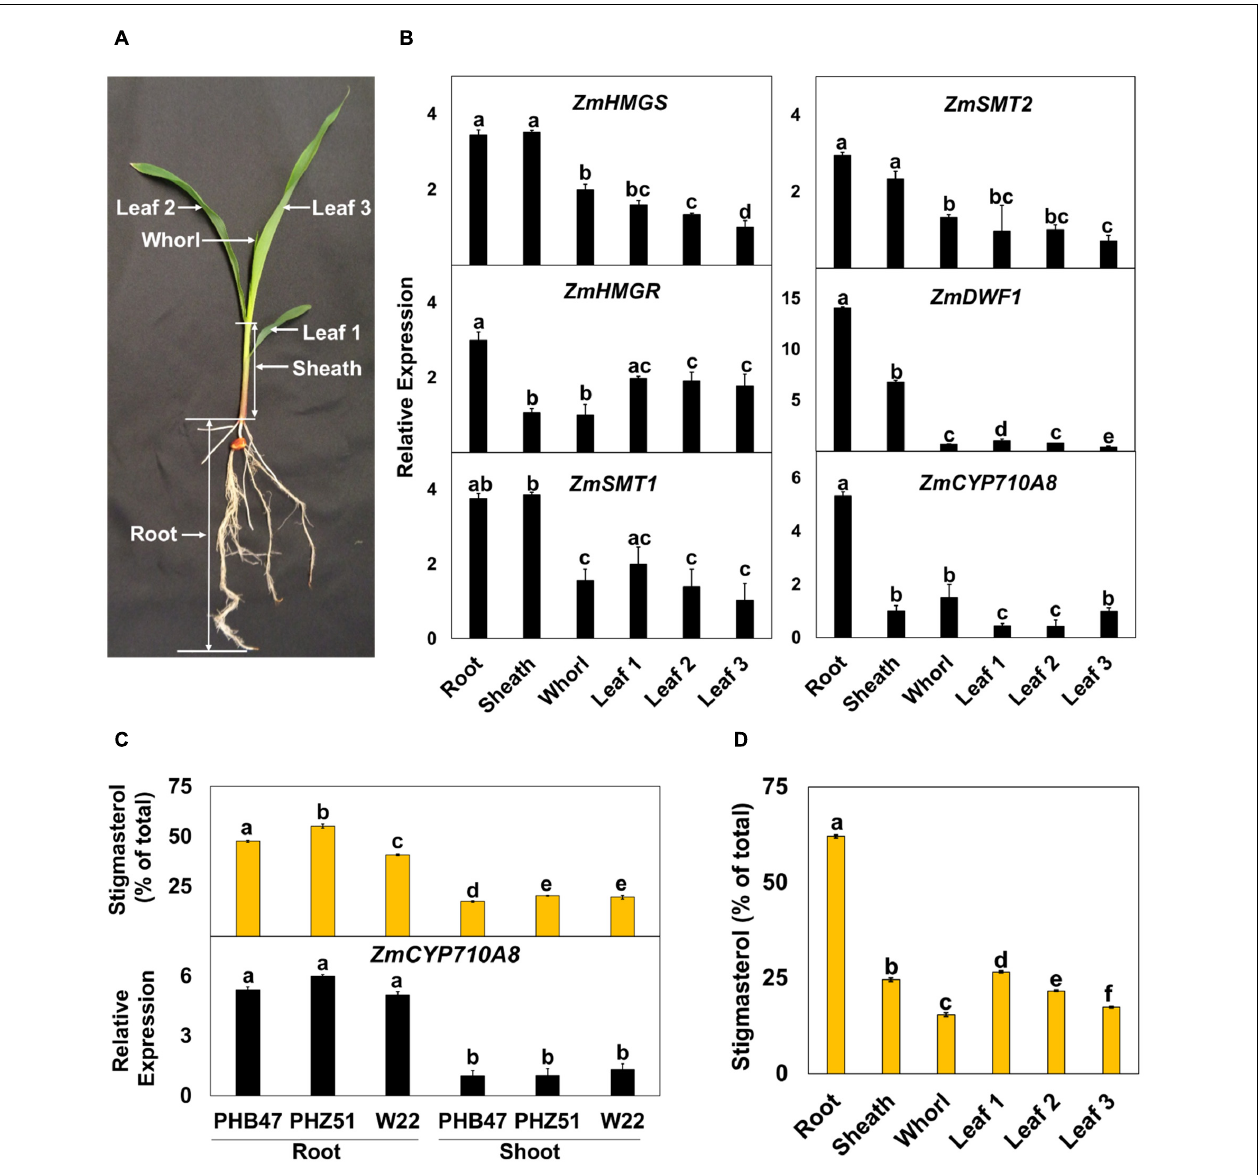
FIGURE 3 | Expression of mRNAs for ZmCYP710A8 and sterol biosynthesis genes correlate with stigmasterol composition during maize development. (A) A representative B73 seedling at the V1 stage and the different organs used in the analysis are shown. (B) Relative mRNA levels of different sterol biosynthesis genes. Tissue samples were pooled from 3 individual seedlings in one experiment. mRNA quantification was done in three replicates. ZmACTIN was used as a reference gene for normalization. Data are means ± SE from two independent experiments. (C) Stigmasterol composition (% of total sterols) and quantification of ZmCYP710A8 mRNA in different maize genotypes. Tissue samples for mRNA and sterol analysis are as described in panel (B) . Root is as shown in panel (A) and shoot is a pool of all the above ground tissue shown in panel (A) . Data are means ± SE from two independent experiments. (D) Stigmasterol composition (% of total sterols) of the different organs of maize B73 at V1 stage is shown. Tissue samples are as described in (b). Sterols were measured in four technical replicates for each experiment. Data are means ± SE from two independent experiments. One-way ANOVA was performed at a 95% confidence interval. Means that do not share a letter were significantly